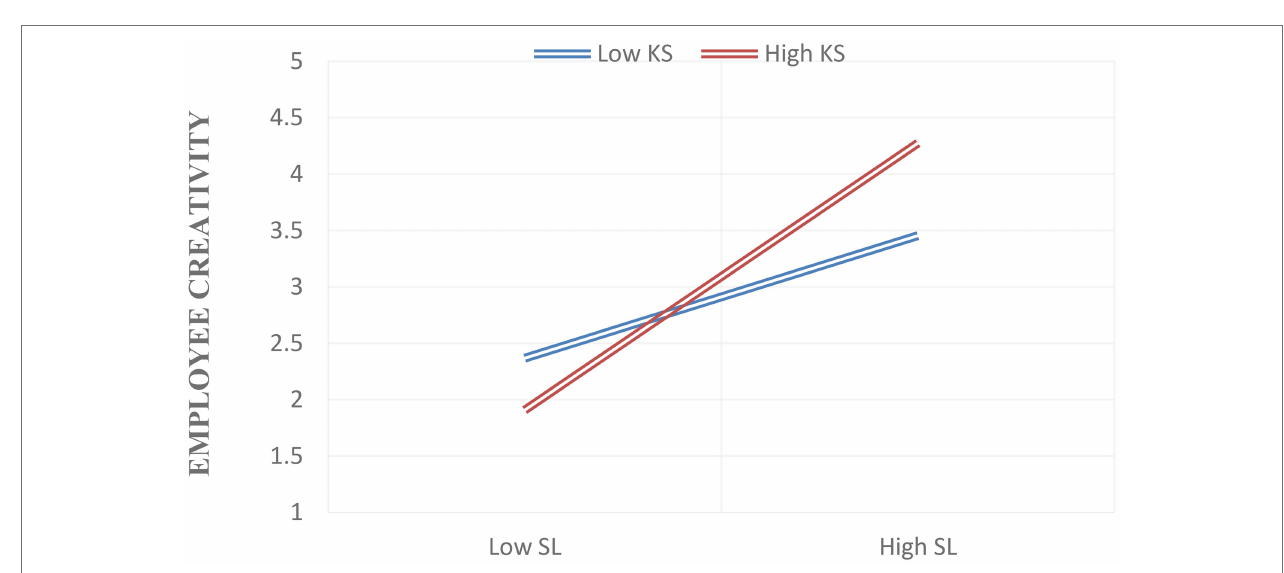
FIGURE 2 | Interaction